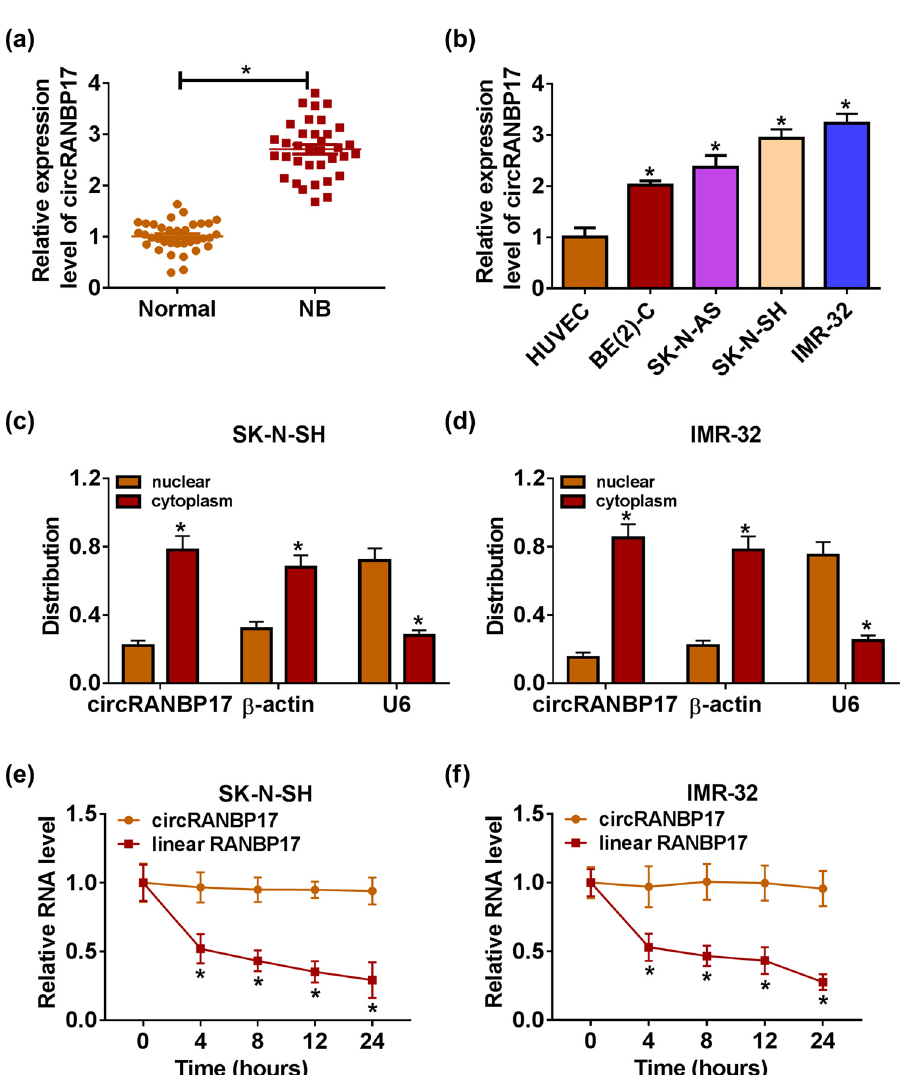
Figure 1: CircRANBP17 is signi fi cantly up - regulated in NB tissues and cells. The level of circRANBP17 in NB tissues ( a ) and cells ( b ) were detected by qRT - PCR. ( c and d ) Location of circRANBP17 in SK - N - SH and IMR - 32 cells was con fi rmed by subcellular fractionation location assay. ( e and f ) Stability of circRANBP17 was identi fi ed by Actinomycin D assay. * P <